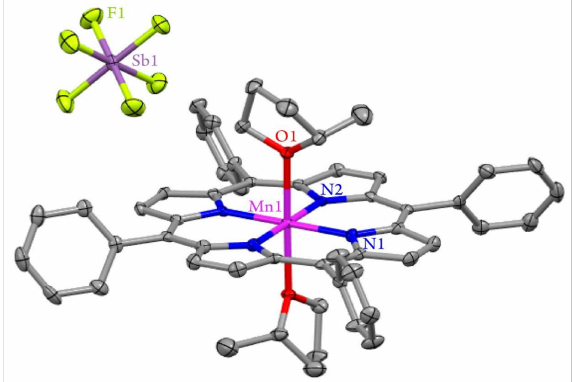
Figure 4. Displacement ellipsoid plot (50% probability level) of [(TPP)Mn III (MeTHF) 2 ]SbF 6 at 100(2) K, showing the atom-labeling scheme. Hydrogen atoms and solvent molecules have been omitted for clarity. Selected bond lengths (Å) and angles (deg): Mn(1)-O(1), 2.272(3); Mn(1)-N(1),